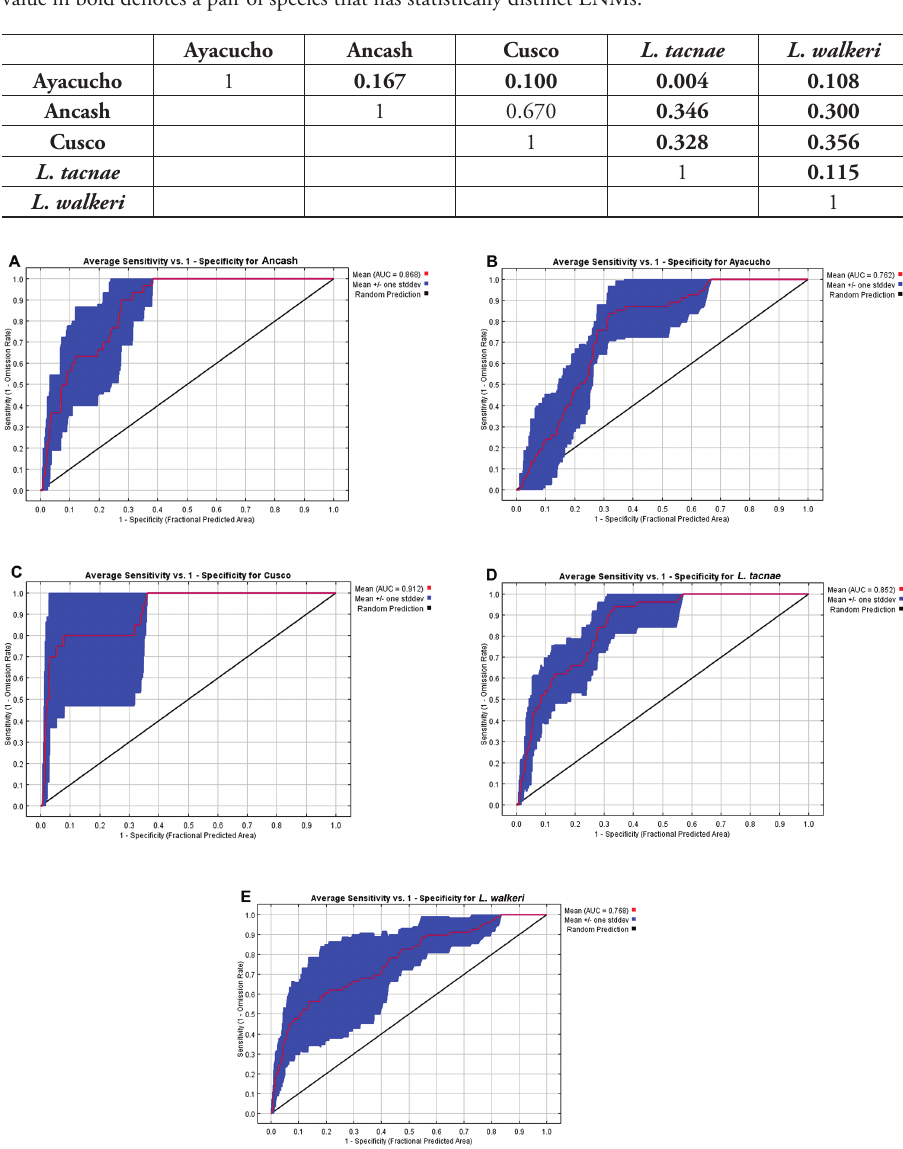
Figure 7. Receiver operating characteristic curves and AUC values for a Ancash B Ayacucho C Cusco D L. tacnae and e L. walkeri